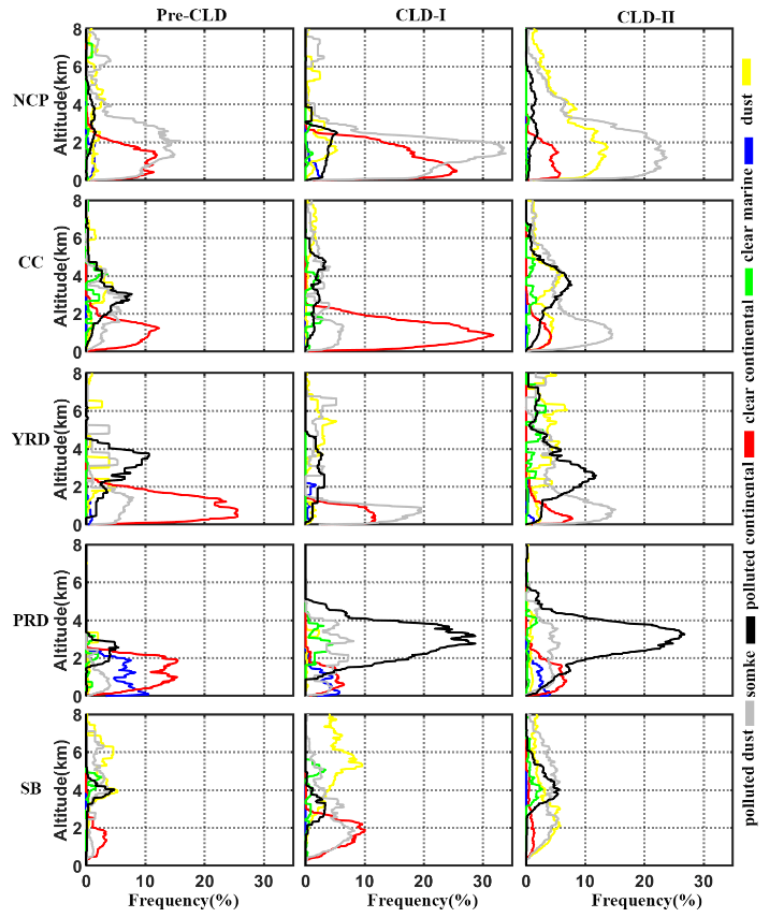
Figure 9. The frequency distribution of each aerosol type within an 8 km altitude for five study areas during the Pre-CLD, CLD-1, and CLD-II periods in 2020. The different colors represent the six aerosol types.